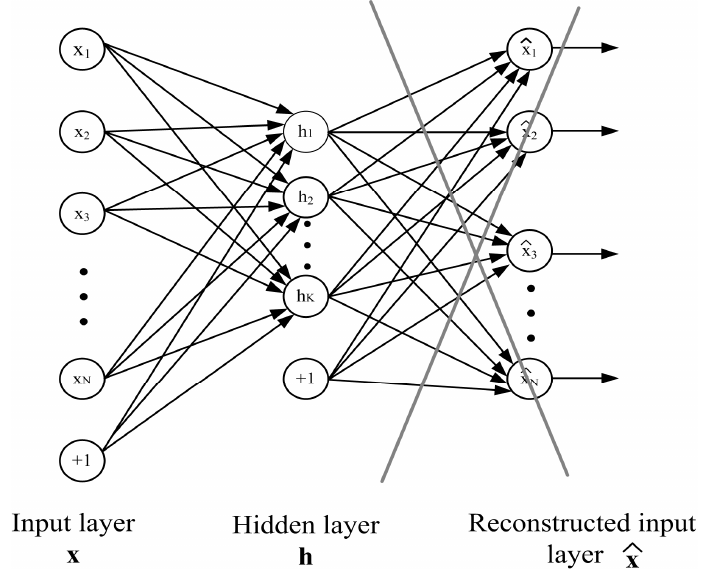
Figure 3. The illustration of the learning process of the hidden layer of the autoencoder. The original input vector x is coded into hidden layer signals forming vector h of reduced dimension by applying the auto-association mode in learning. After finishing the learning procedure, the output layer is eliminated, and vector x is represented by reduced size vector h .